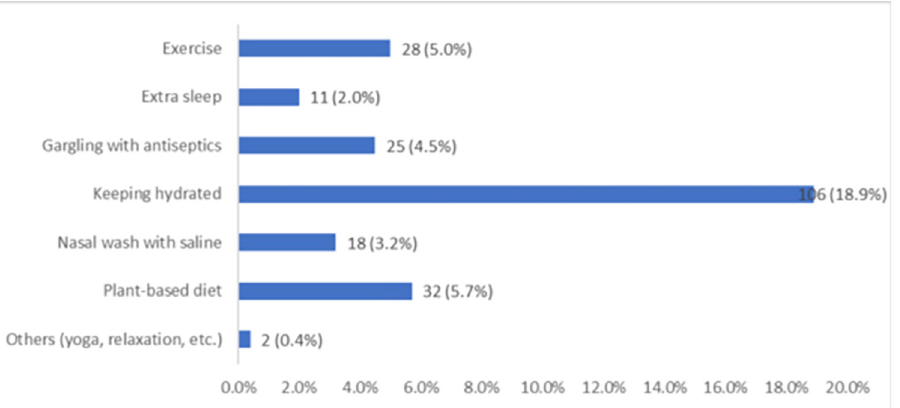
Fig 2. Types of nonpharmacological methods used for COVID 19 prophylaxis (N = 197).